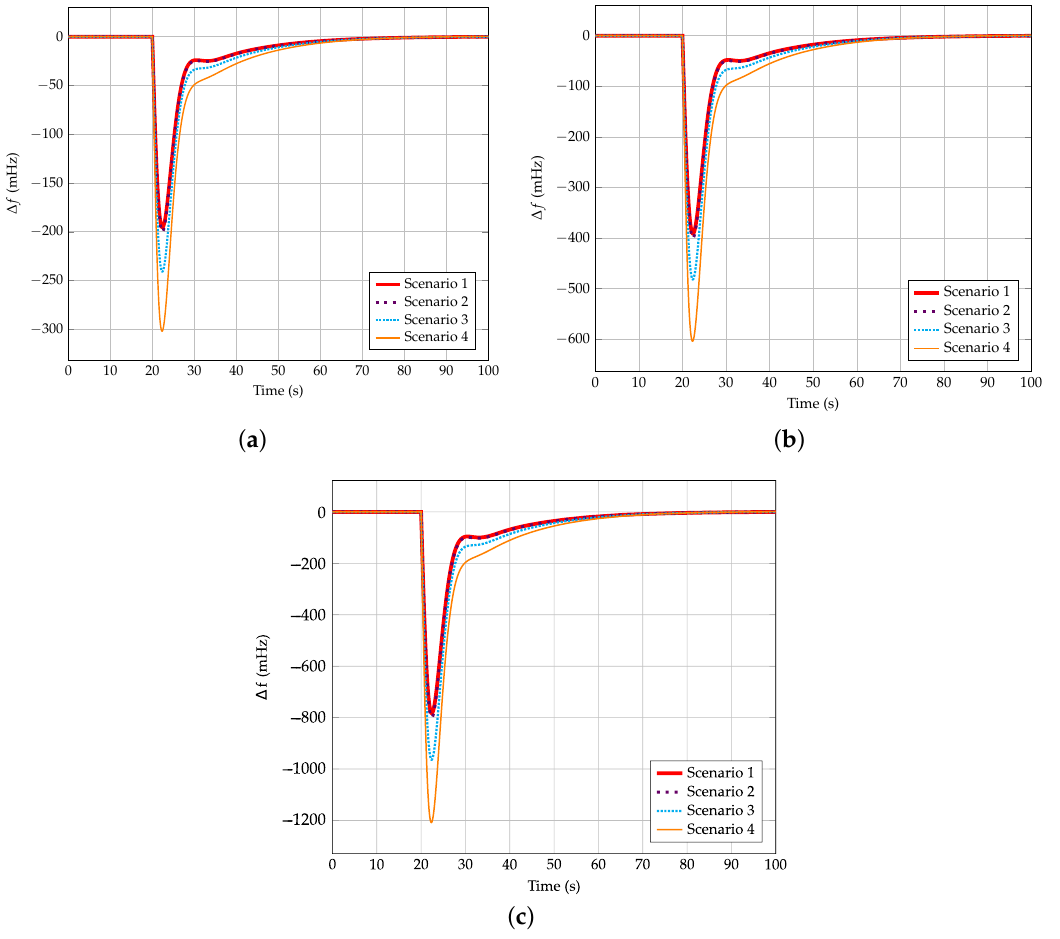
Figure 12. Frequency excursions for scenarios 1–4 without wind power plant control. ( a ) Considering ∆ P L = 0.025; ( b ) Considering ∆ P L = 0.050; ( c ) Considering ∆ P L =